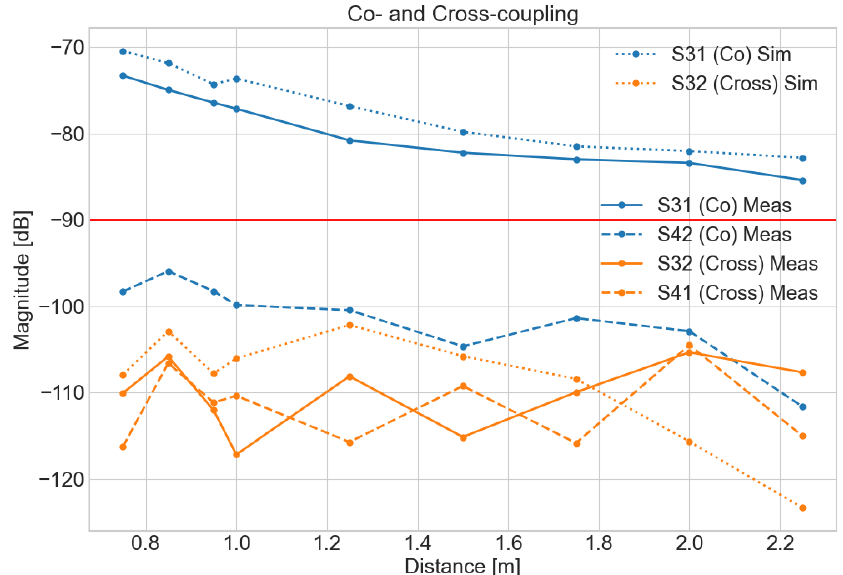
Figure 6. Simulation and measurement results for selected co- and cross-coupling parameters. Both simulated and measured data sets show the antenna coupling in dB at a chosen frequency of f sel = 1.2575GHz for various distances between the antenna centers. The target decoupling of 90dB is marked in red.